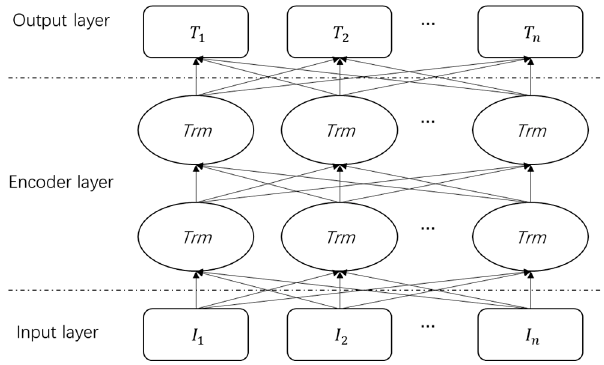
Figure 3. BERT model structure.